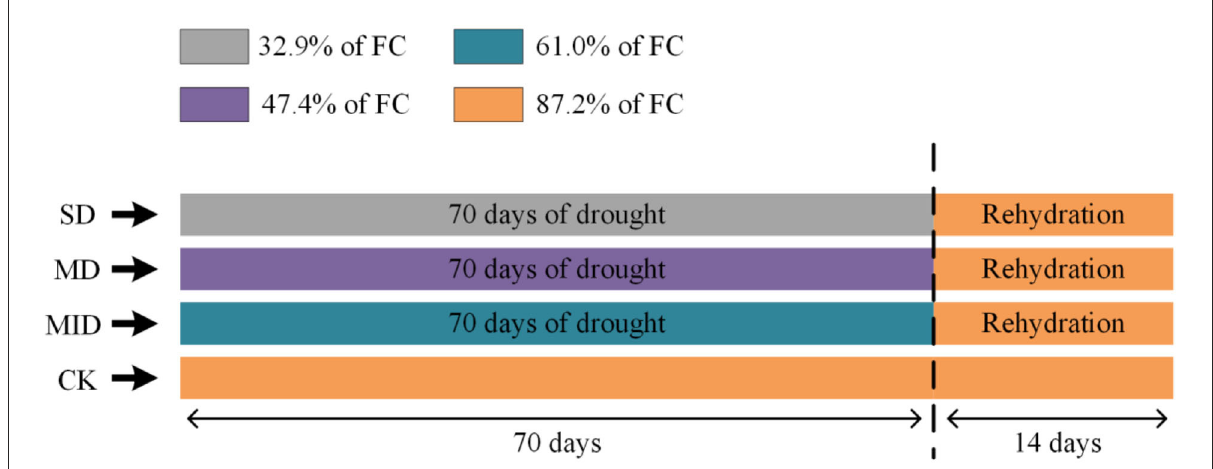
FIGURE1 The water treatment design was carried out using A. selengensis as the testing material. FC, field water-holding capacity; SD, severe drought group; MD, severe drought group; MID, mild drought group; CK, control group. After the drought experiment (70 days), SD, MD, and MID treatments were re-watered to the control level (14 days). Samples were taken every 14 days for